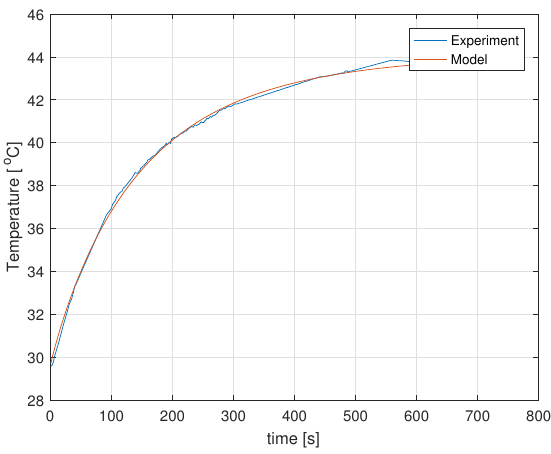
Figure 6. The step responses of the FO model and real plant for area 2.